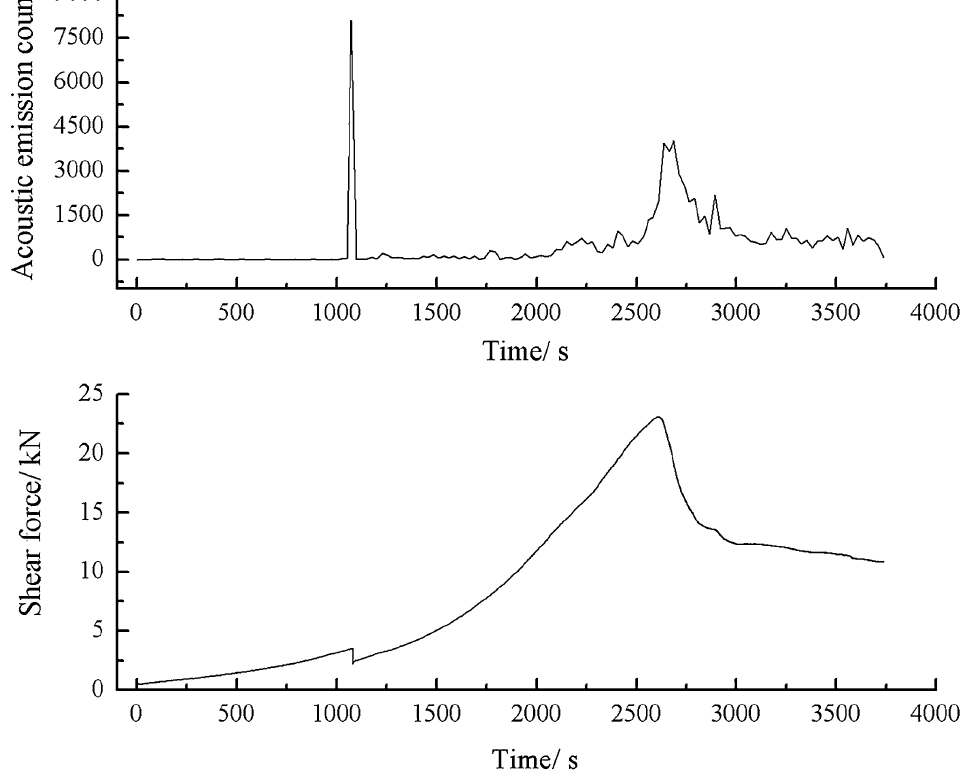
Figure 51. Shear stress–time and count-time curves for a specimen containing 1–2.56 mm sand particles (one grain size